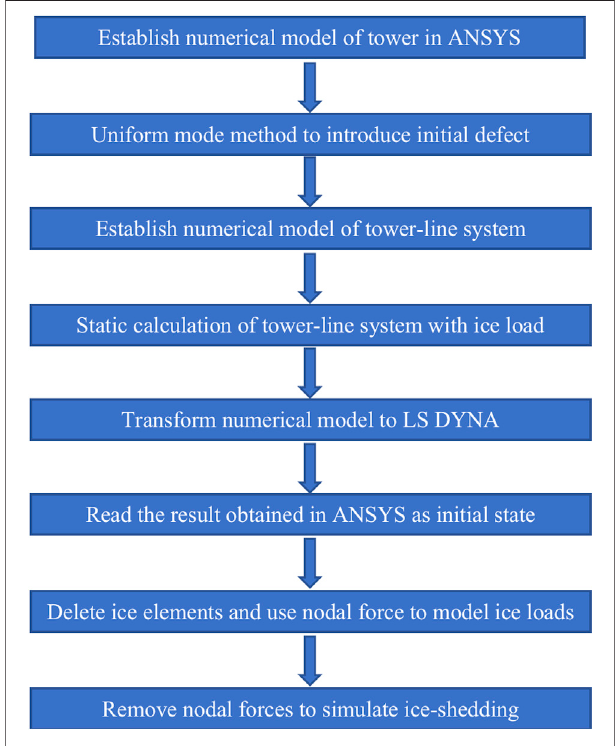
FIGURE 4 | Flowchart for the dynamic analysis of ice